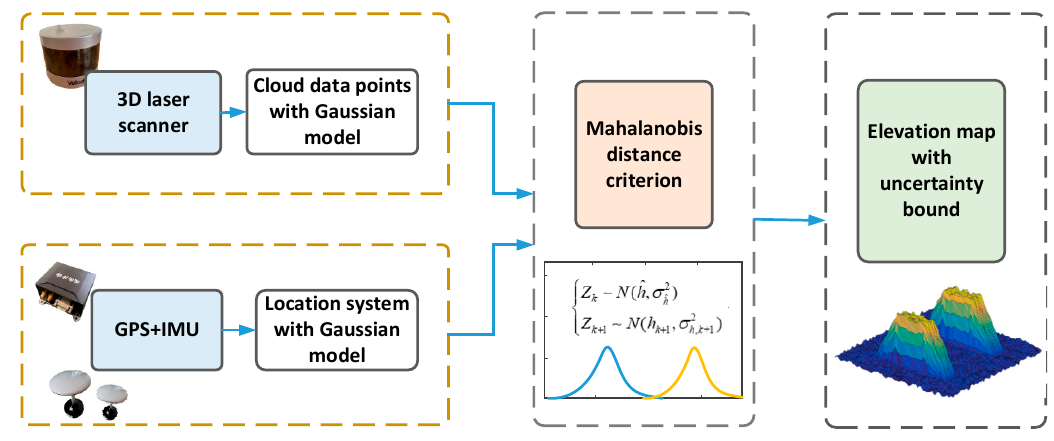
Figure 5. Probability map estimation system.